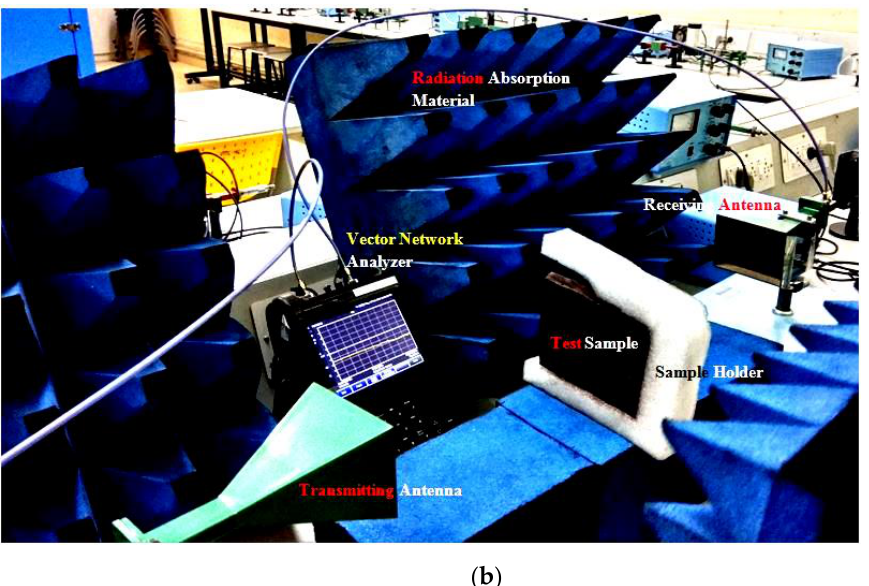
Figure 2. ( a ) Schematic diagram of EMI test setup. ( b ) Experimental setup for the Electromagnetic Interference test.